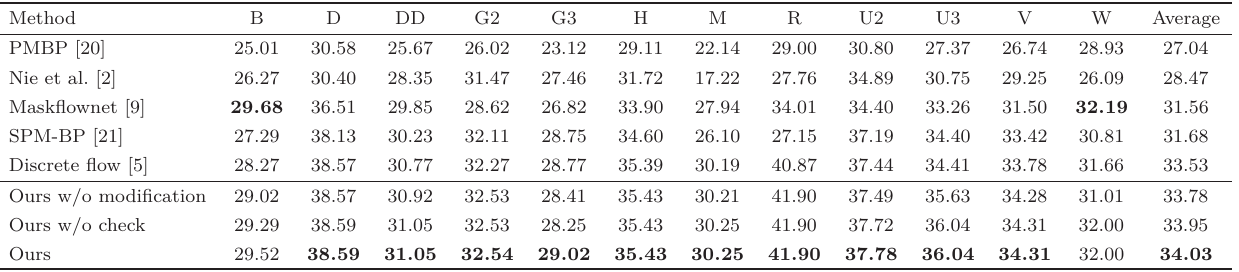
Table 1 Interpolation error (PSNR) for the Middlebury benchmark. Image pairs: B: Beanbags, D: Dimetrodon, DD: DogDance, G2: Grove2, G3: Grove3, H: Hydrangea, M: MiniCooper, R: RubberWhale, U2: Urban2, U3: Urban3, V: Venus, W: Walking